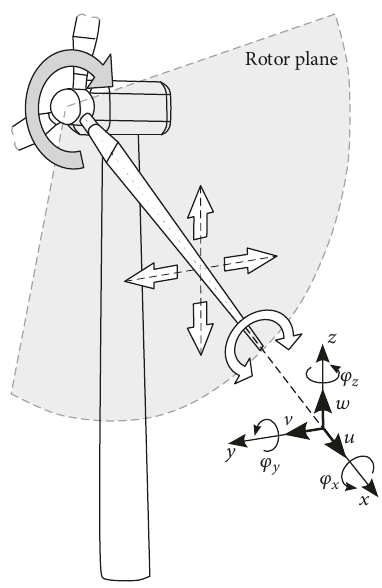
Figure 4: Fundamental types of vibrations of wind turbine blades.